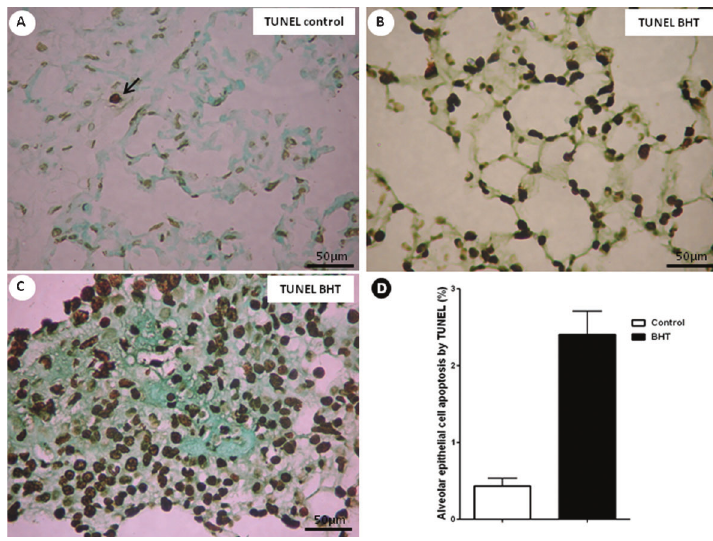
Figure 2. Apoptosis in lung tissues at day 28. Histological sections of representative TUNEL- stained lung sections from 3-5-di-tert-butyl-4- hydroxytoluene (BHT)-treated mice and a control group are shown. A , Control group showed sparse alveolar epithelial cells in apoptosis. B , C , BHT-treated mice exhibited numerous apop- totic alveolar epithelial cells in normal ( B ) and fibrotic ( C ) areas. D , Effects of BHT on alveolar epithelial cell apoptosis expression detected by TUNEL. Results are reported as area fraction (%) occupied by apoptosis in the alveolar septa. Data are reported as means±SD, n=20 for the BHT group and n=10 for the control group. P=0.02, BHT vs control (Student t